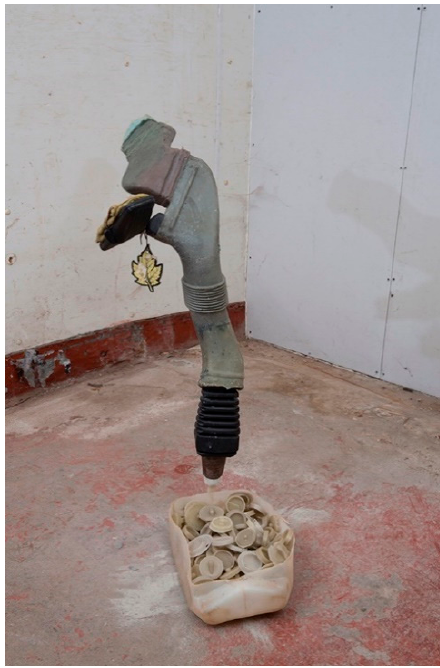
Figure 13. Matthias. 2016. Os Coxa Diaphragm Chamber 142 , featured in S-O-T Body Repairs exhibition.